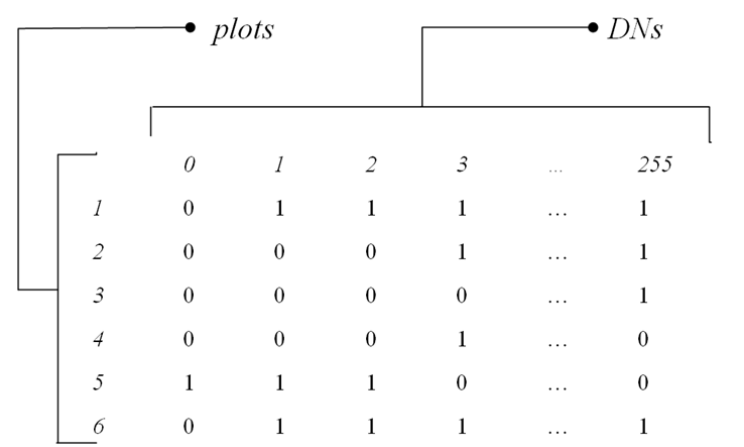
of N plots per S DN values. Notice that DN